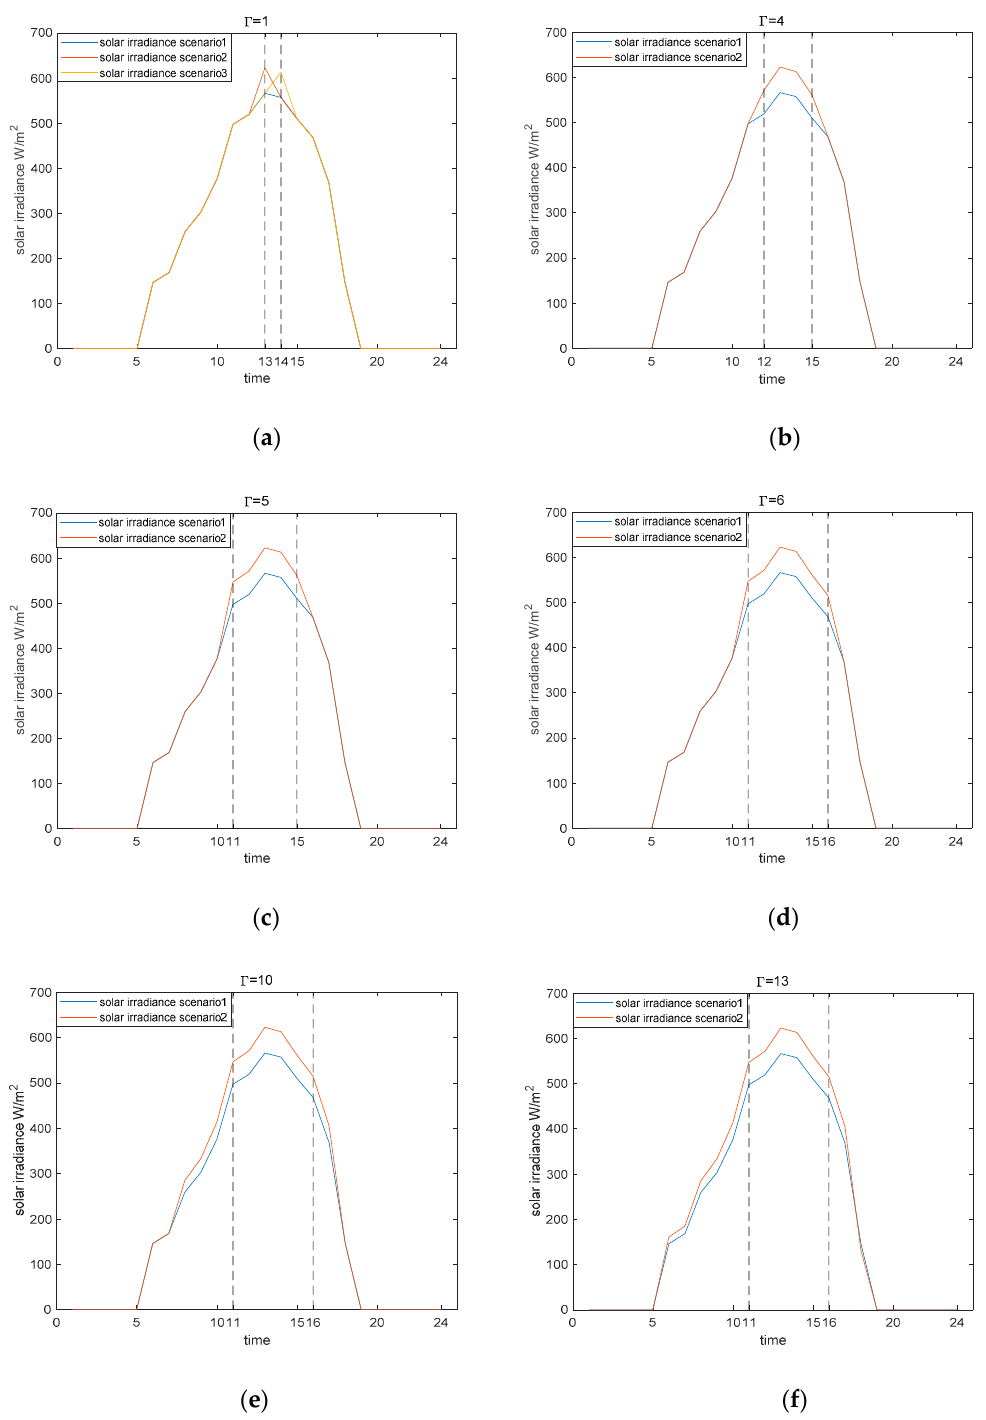
Figure 12. The iterative process of the algorithm for different uncertainty budgets. ( a ) iterative process when Γ = 1; ( b ) iterative process when Γ = 4; ( c ) iterative process when Γ = 5; ( d ) iterative process when Γ = 6; ( e ) iterative process when Γ = 10; ( f ) iterative process when Γ = 13.